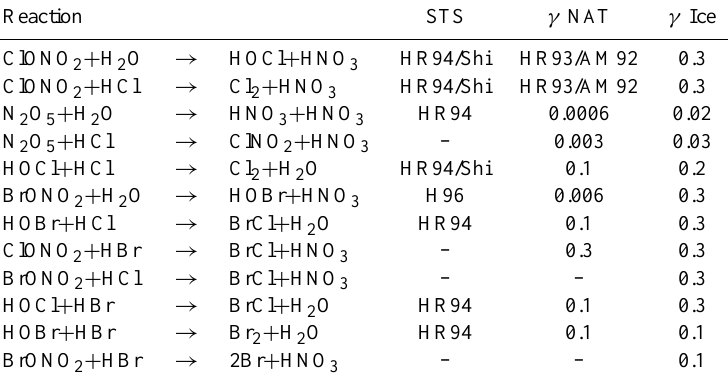
Table 2. List of heterogeneous reactions included in the model. The cloud types on which the reactions take place are indicated (STS = supercooled ternary solution, NAT = nitric acid trihydrate). The first column shows parameterisations for reaction rate coefficients. The last two columns give gas-surface reaction probabilities γ or parameterisations for γ . Parameterisations are indicated by HR94 = Hanson and Ravishankara (1994) and Hanson et al. (1994), Shi = Shi et al. (2001), HR93 = Hanson and Ravishankara (1993), AM92 = Abbatt and Molina (1992), H96 = Hanson et al. (1996). Reaction